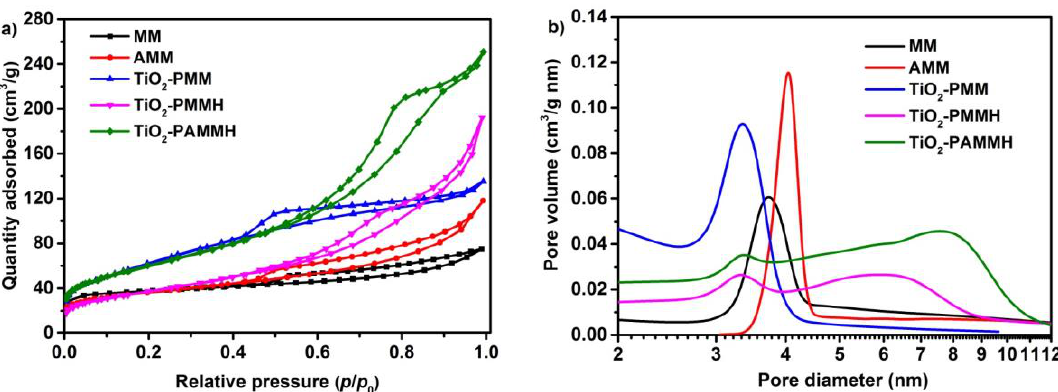
Figure 2. Nitrogen adsorption / desorption isotherms ( a ) and pore size distribution ( b ) of the samples MM, AMM, TiO 2 -PMM, TiO 2 -PMMH and TiO 2 -PAMMH.